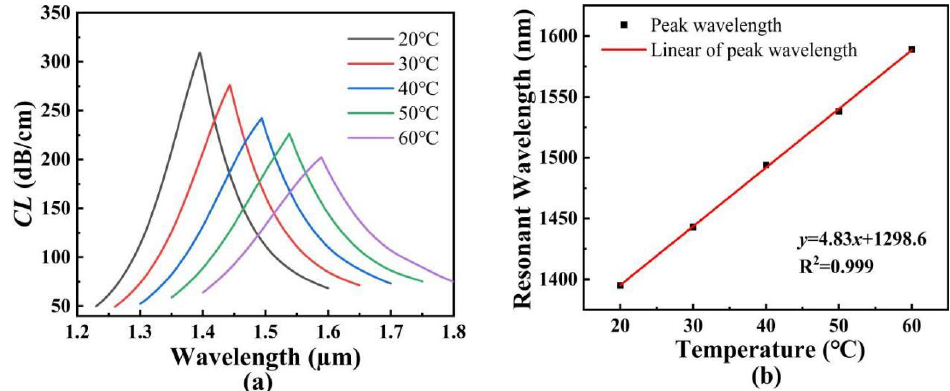
Figure 11. ( a ) The CL spectra of the core mode B. ( b ) The variation of the resonant wavelength of the core mode B with the temperature, and its fitting result. Table 2. Comparison results of the sensitivities of the proposed SPR-based PCF sensor with other works.